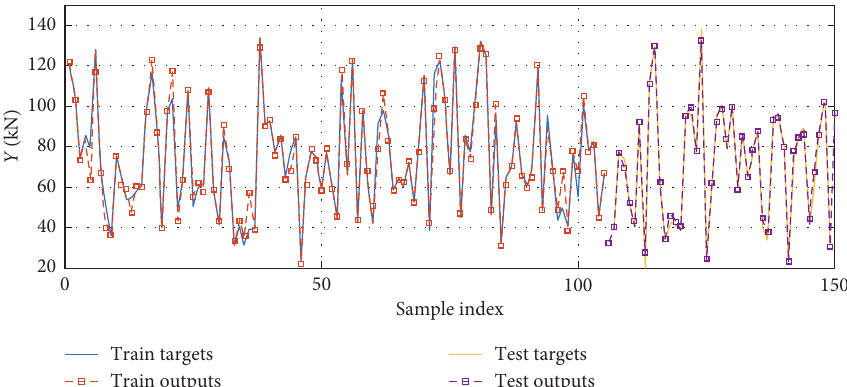
Figure 8: Experimental and predicted load-carrying capacity in function of sample index for the training and testing datasets.